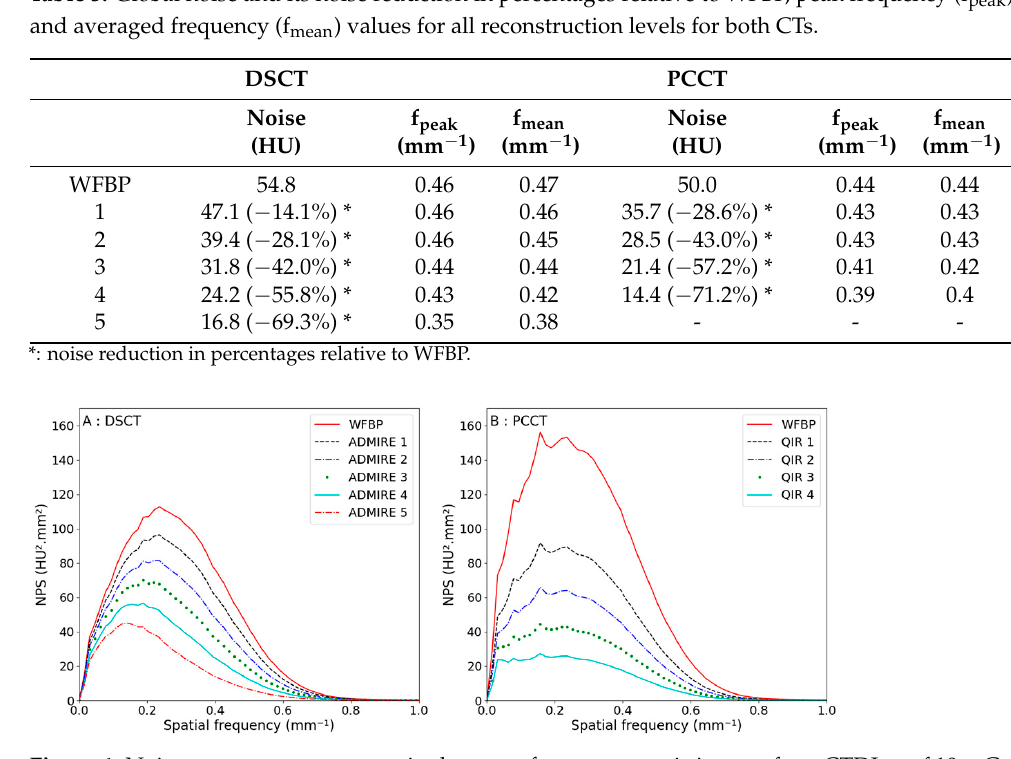
Figure 4. Noise power spectra curves in the case of monoenergetic images for a CTDI vol of 10 mGy when increasing the reconstruction level for the DSCT ( A ) and the PCCT ( B ). Table 4. Global noise and its noise reduction in percentages relative to WFBP, peak frequency (f peak ) and averaged frequency (f mean ) values for all reconstruction levels for both CTs for a 10 mGy